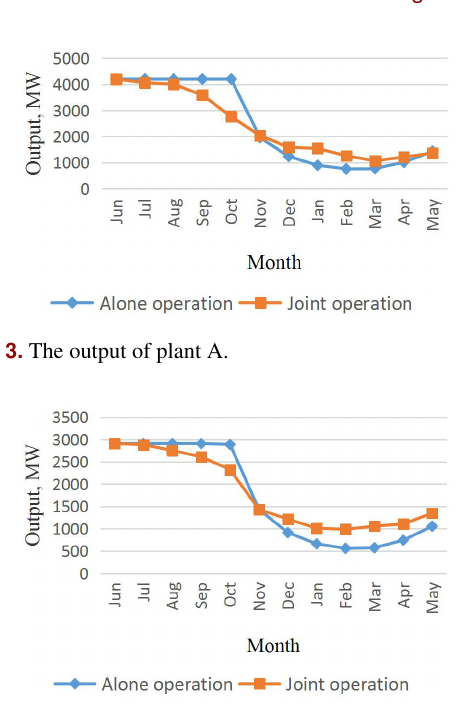
Figure 6. The output of plant